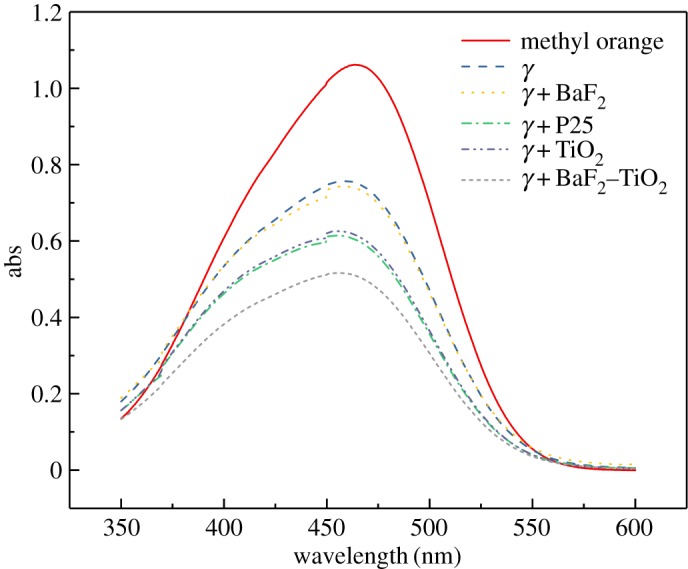
Ultraviolet–visible spectra before and after γ-ray irradiation of methyl orange solutions with different catalysts (CBaF2, CTiO2, CP25: 1 g l−1; C0.75-BaF2–TiO2: 1.75 g l−1).